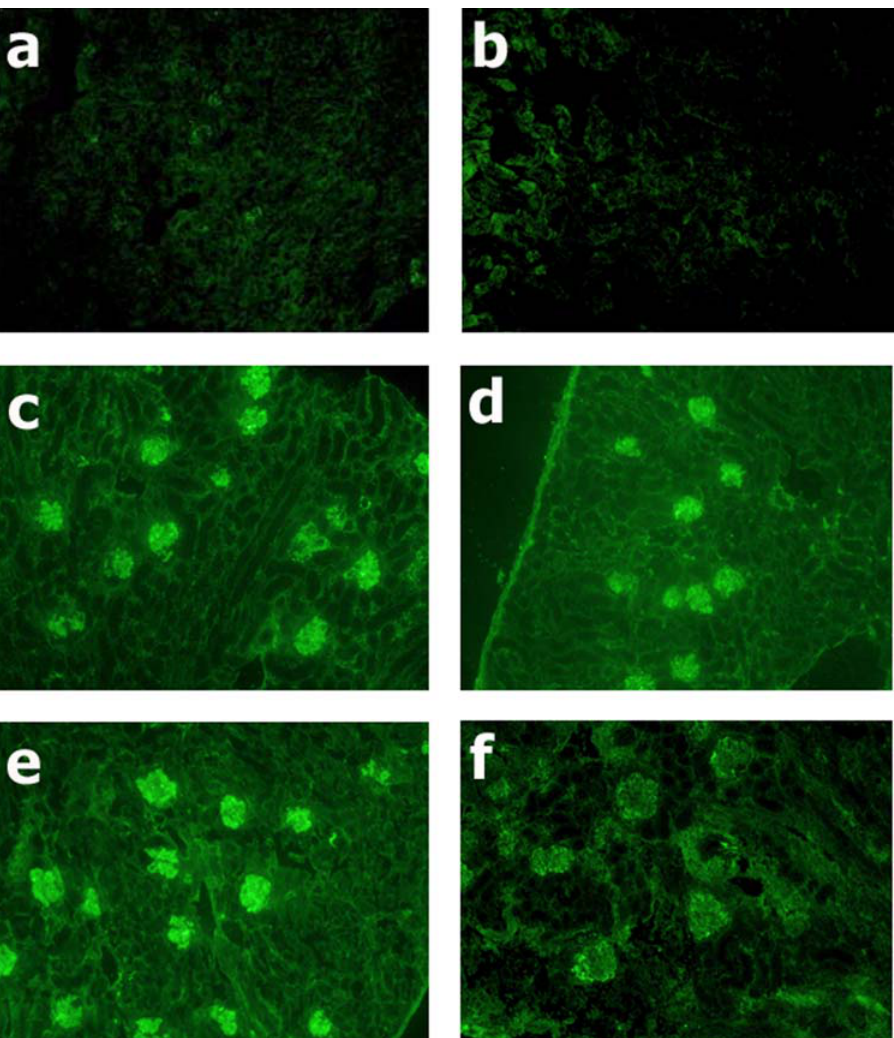
Figure 3. Immunohistochemical localization of CD14. Sections were stained with rat anti-mouse CD14 followed by goat anti-rat IgG labeled with FITC; magnification 6 100. a: WT mouse treated with saline. b: C3KO mouse treated with saline. c: WT IR /WT mouse treated with HSA/LPS. d: C3KO IR /WT mouse treated with HSA/LPS. e: WT IR /C3KO mouse treated with HSA/LPS. f: C3KO IR /C3KO mouse treated with HSA/LPS.